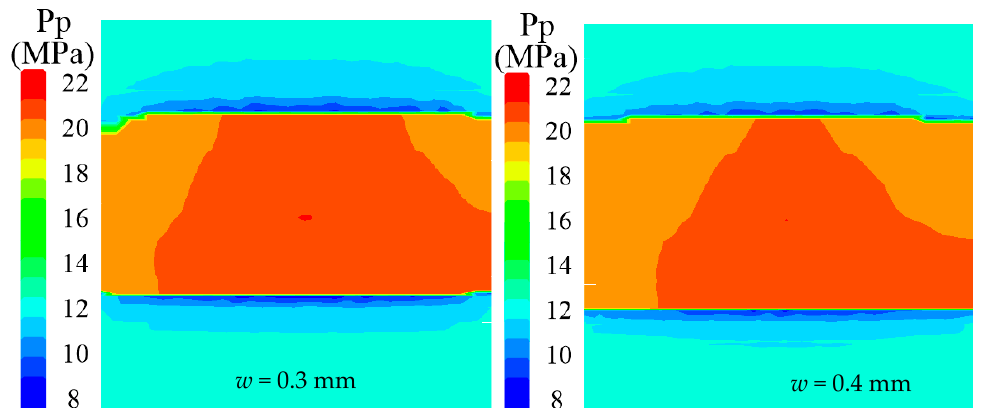
Figure 16. Fluid pressure distributions in different cases, with the bedding aperture varying from w = 0.1 mm to 0.2 mm, 0.3 mm and 0.4 mm.